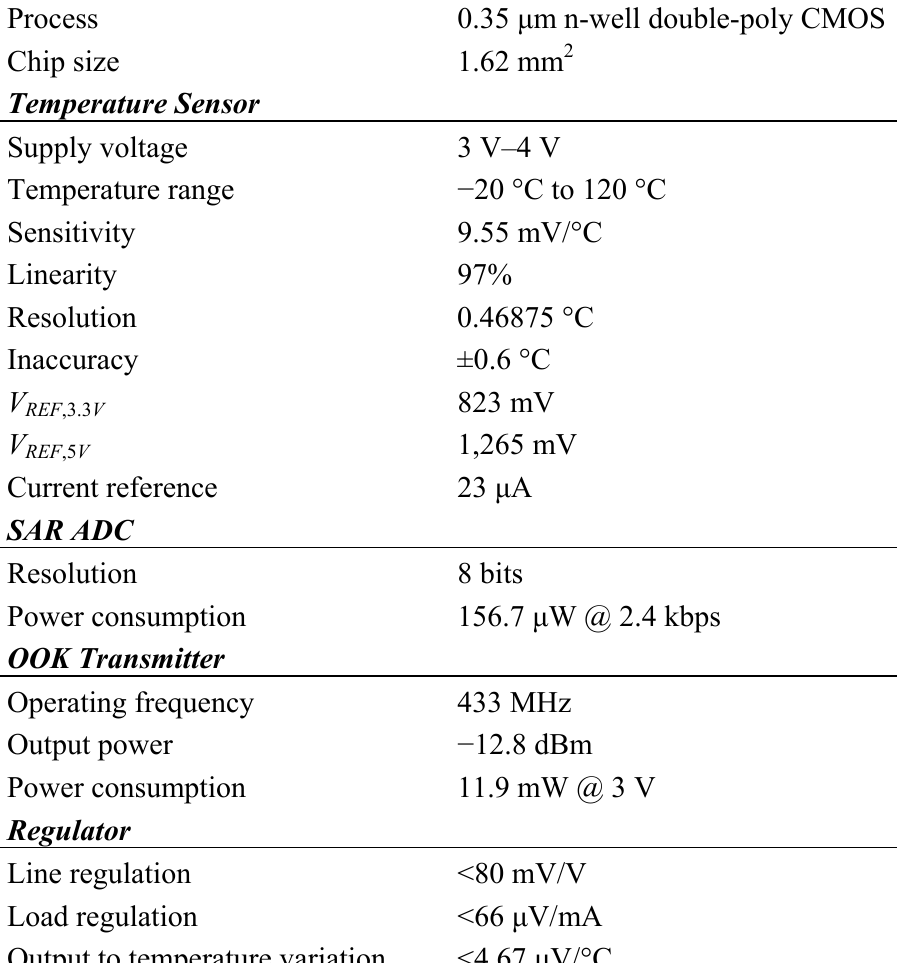
Table 1. Performance